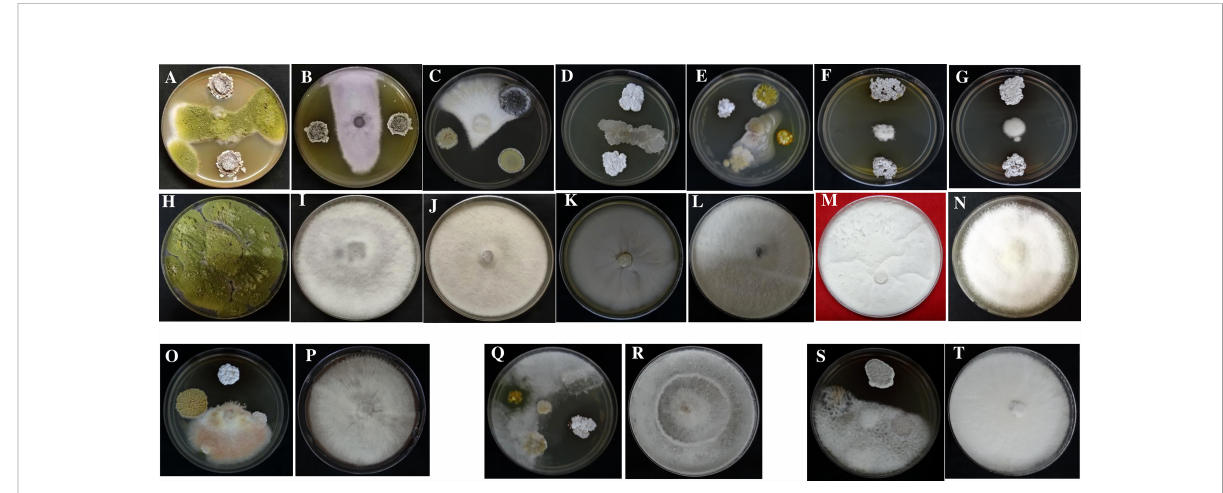
FIGURE 4 Antifungal activity of endophytic actinobacteria against fungal phytopathogens (A) Colletotrichum capsici (MTCC 8473) treatment and (H) Control; (B) Fusarium oxysporum (MTCC 284) treatment and (I) Control; (C) Fusarium solani (MTCC 365) treatment (J) Control; (D) Nigrospora sphaerica (KJ767520) treatment and (K) Control; (E) Phellinus lamaensis (ITCC 292) treatment and (L) Control; (F) Poria hypobrunnea (ITCC 4141) treatment and (M) Control; (G) Glomerulla cingulata (MTCC 2033) treatment and (N) Control; (O) Rhizoctonia solani (MTCC 4633) treatment and (P) Control; (Q) Curvularia eragrostidis (MTCC 8198) treatment and (R) Control; (S) Pestalotiopsis theae (ITCC 6599), treatment and (T)